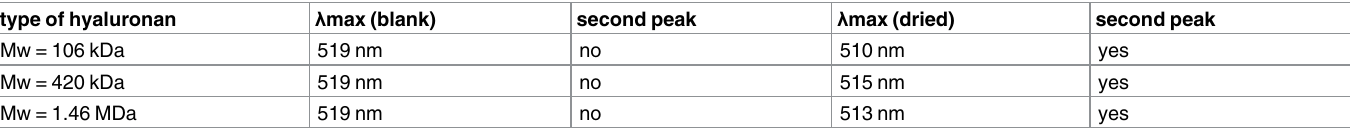
Table 4. Wavelengths of maximum peaks for samples with prodan as a fluorescence probe and the presenceof the second peak in the spectra. type of hyaluronan